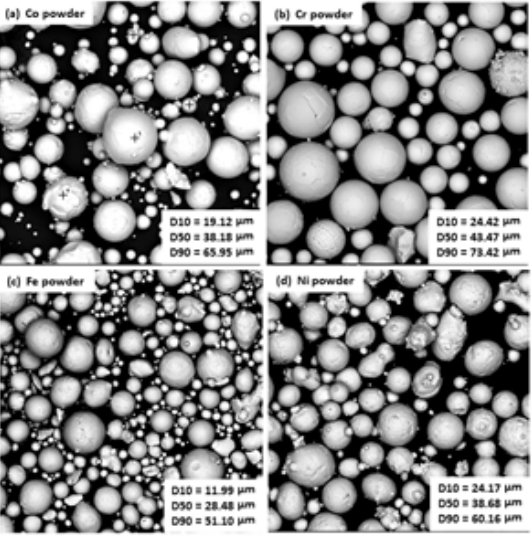
Figure 1. SEM (scanning electron microscope) image and particle size distribution of elemental powder. ( a ) cobalt powder ( b ) chromium powder ( c ) iron powder ( d ) nickel powder.